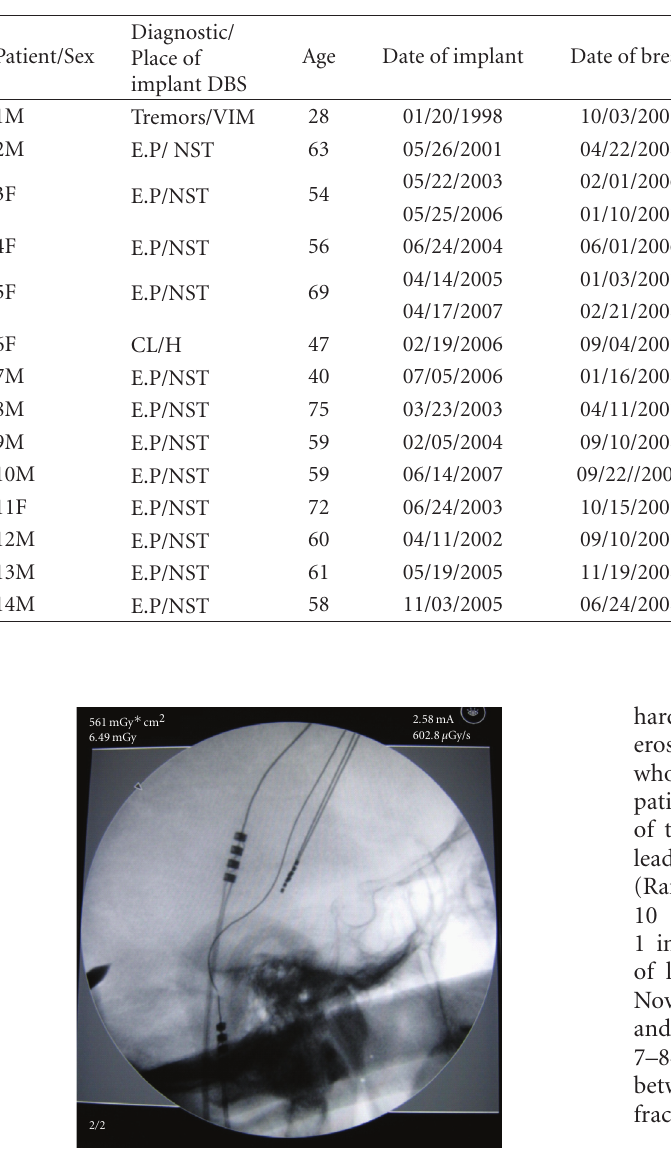
Table 1: C1, C2, C3, C5, C6: cervical vertebral body. CL: cluster headache. DBS: deep brain stimulation. H: hypothalamus. M: male. F: